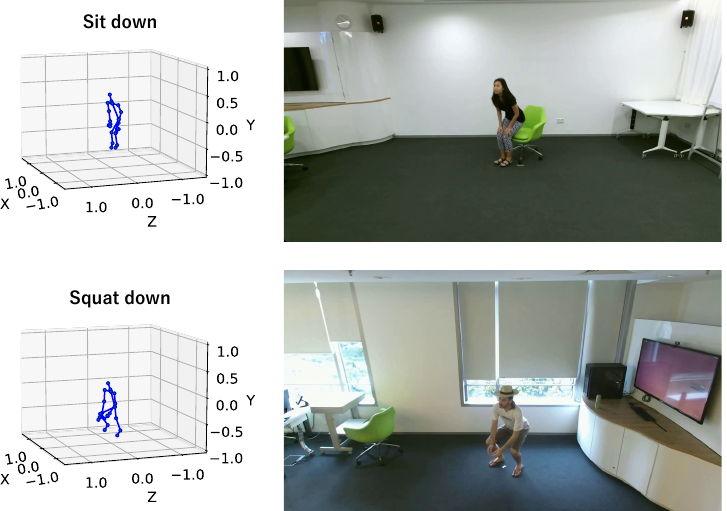
Figure 5. Examples of 3D skeletons and RGB images in the NTU RGB+D 120 dataset. The upper one shows “sit down” and the lower one shows “squat down”. The 3D human skeletons are on the left and the RGB image are on the right.